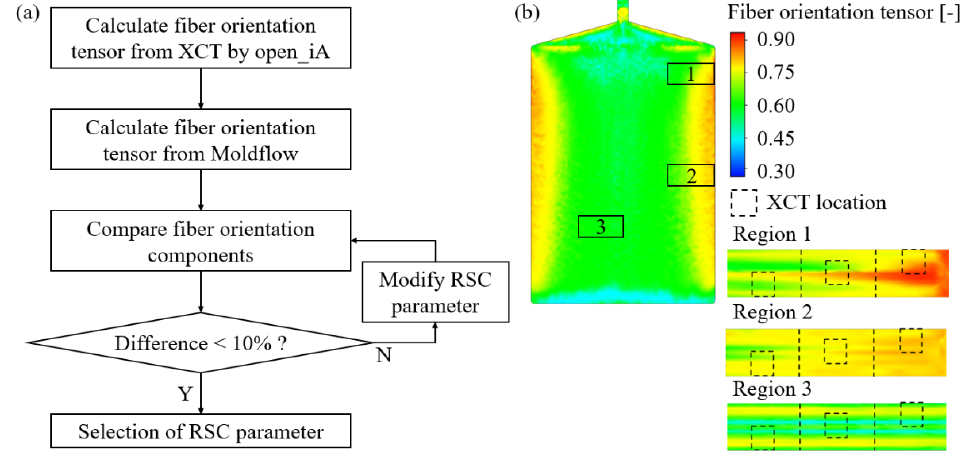
Figure 5. ( a ) The procedure to determine the RSC parameter by comparison of fiber orientation tensor obtained from XCT data and Moldflow simulation results. ( b ) The locations of XCT samples in the PA6-CF injection molded plate.